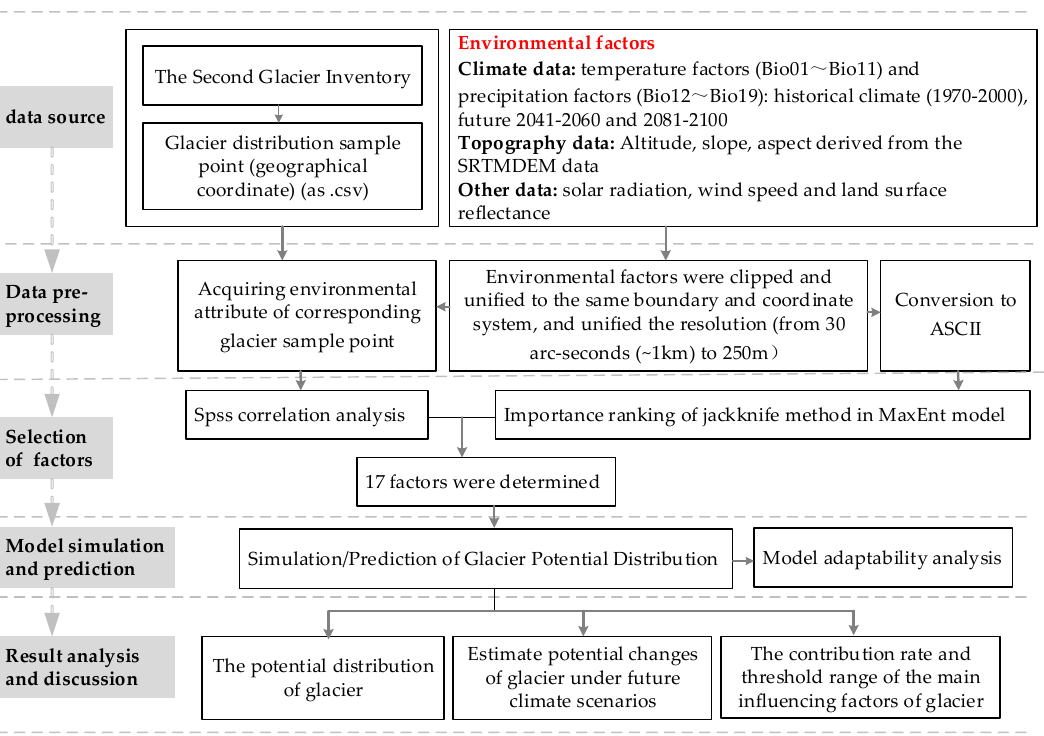
Figure 2. Workflow of the MaxEnt model for the glacier potential distribution.